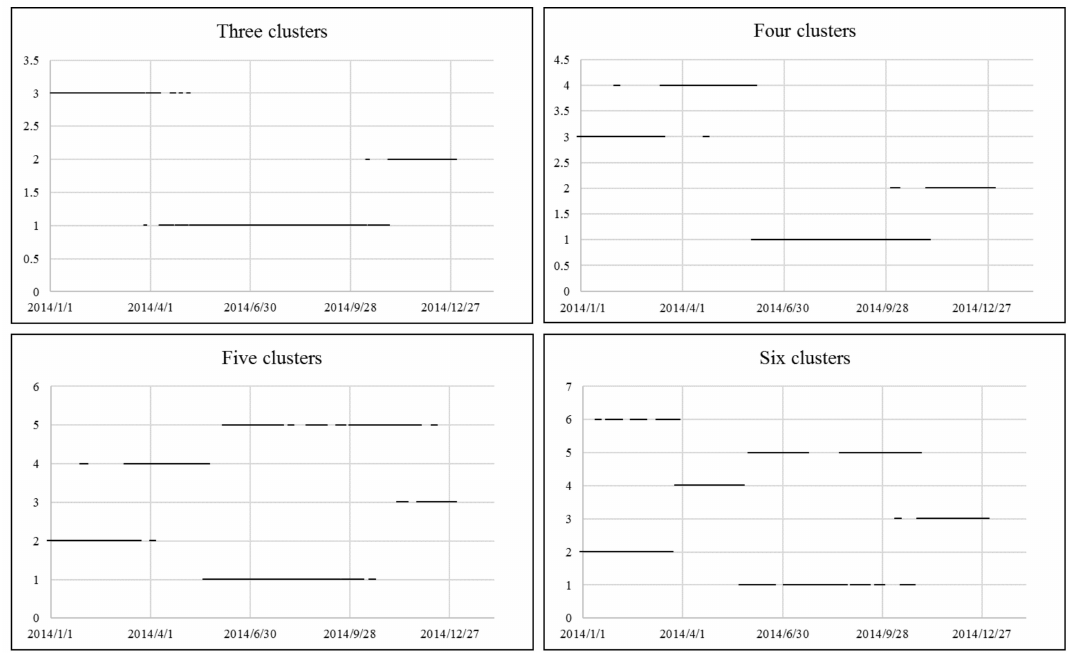
Figure 4. Results of seasonal clustering for the data pertaining to